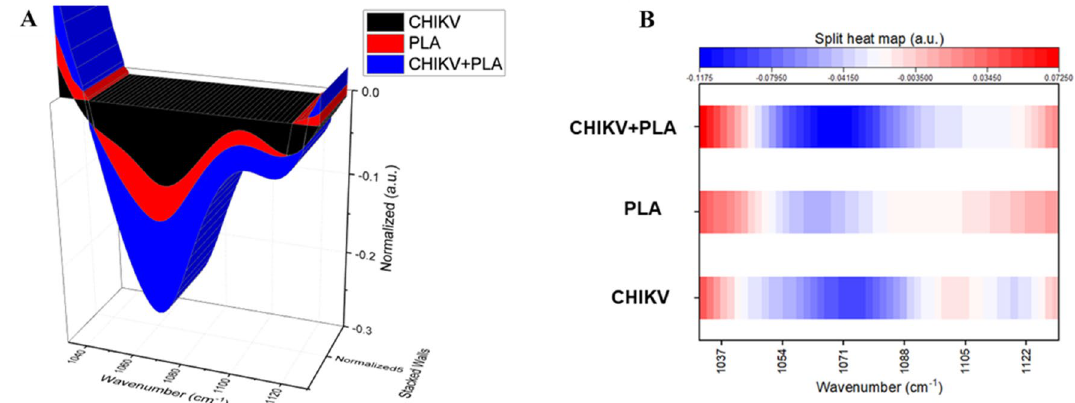
Figure 9. Infrared spectroscopy Spectral analysis between CHIKV virion and PLA CB . A representative Stacked Walls ( A ) and split heat map ( B ) of the infrared average spectrum of second derivative analysis from PLA2 CB (red), CHIKV virions (black), and PLA2 CB plus CHIKV virions (blue). All images were generated using GraphPad Prism 8 and GIMP 2.10.20 (www. gimp.